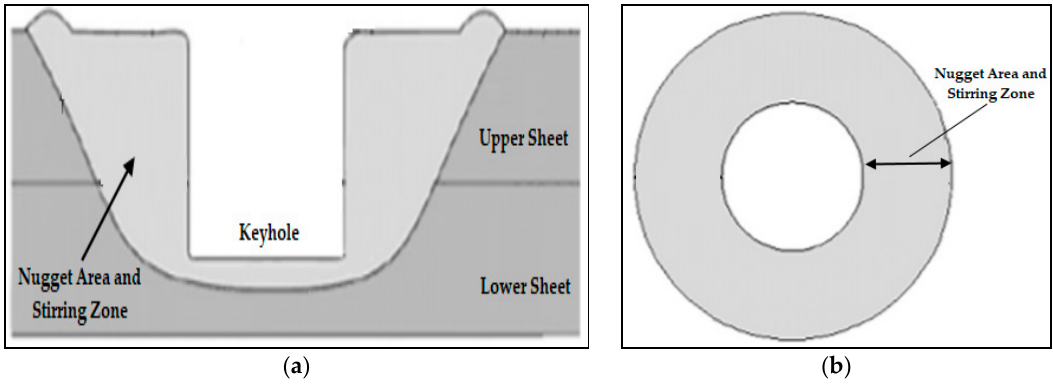
Figure 10. ( a ) The cross-section view of the friction stir spot welding and ( b ) top view of the nugget area and the stirring zone [12].